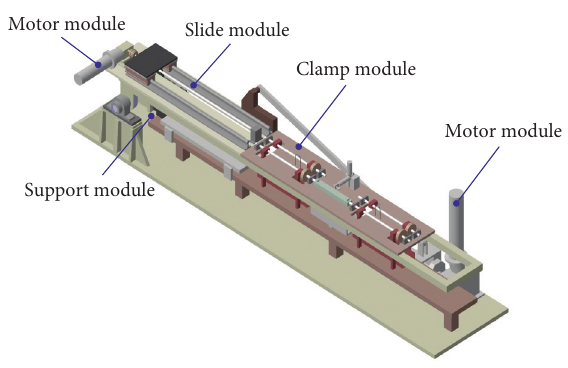
Figure 5: 3D view of SF assembly’s down-ender.